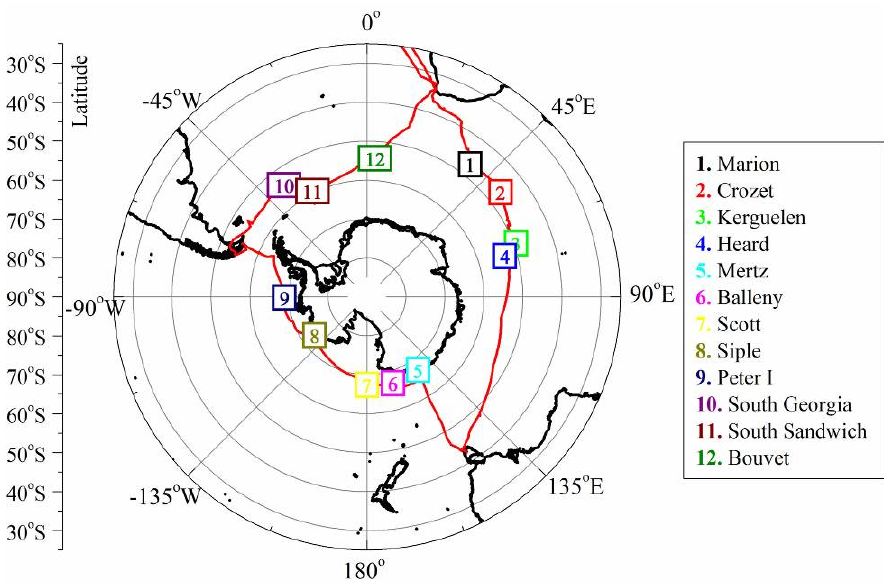
Figure 2. Geographic positions of islands on the route of the RV Akademik Tryoshnikov (62nd RAE). The measurements of the concentrations of aerosol and light-absorbing